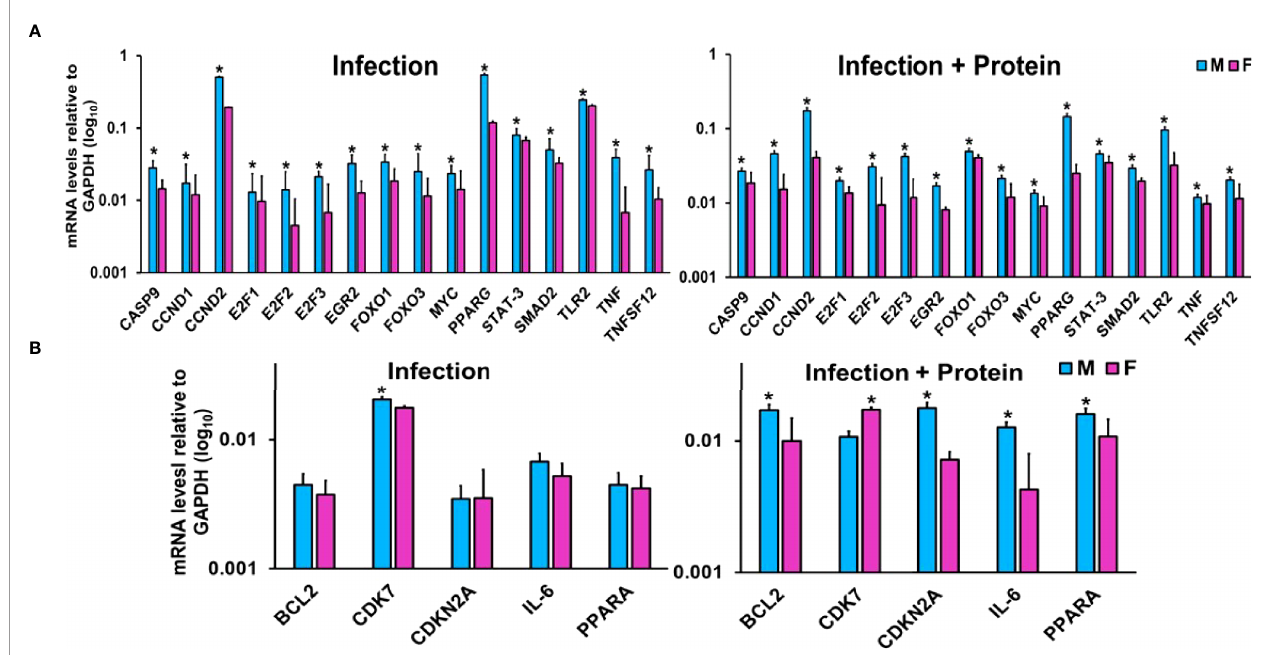
FIGURE 3 | Effect of infection and infection plus SP-A2 (1A 0 ) protein rescue on miRNA-mRNA targets. Panels A, B show the gene expression levels in KO male and female mice. Signi fi cant sex differences after infection in the expression levels of CASP9, CCND1, CCND2, E2F1, E2F2, E2F3, EGR2, FOXO1, FOXO3, MYC, PPARG, SMAD2, STAT-3, TLR2, TNF, and TNFSF12 (upregulated in male mice compared to female mice) are shown in panel (A) on the left. The expression levels of BCL2, CDK7, CDKN2A, IL-6, and PPARA after infection that exhibited no changes between sexes in response to infection except CDK7 (showed a signi fi cant increase in male mice) are shown in panel (B) on the left. However, in response to infection plus protein rescue, all of the genes exhibited an increase in male vs. female mice ( A, B on the right) except the CDK7 that exhibited an increase (p < 0.05) in female mice ( B on the right). The expression levels of speci fi c mRNA targets were normalized to GAPDH and are depicted by blue and pink bars, respectively, for male and female mice. An asterisk (*) marks the differences (p < 0.05) between male and female